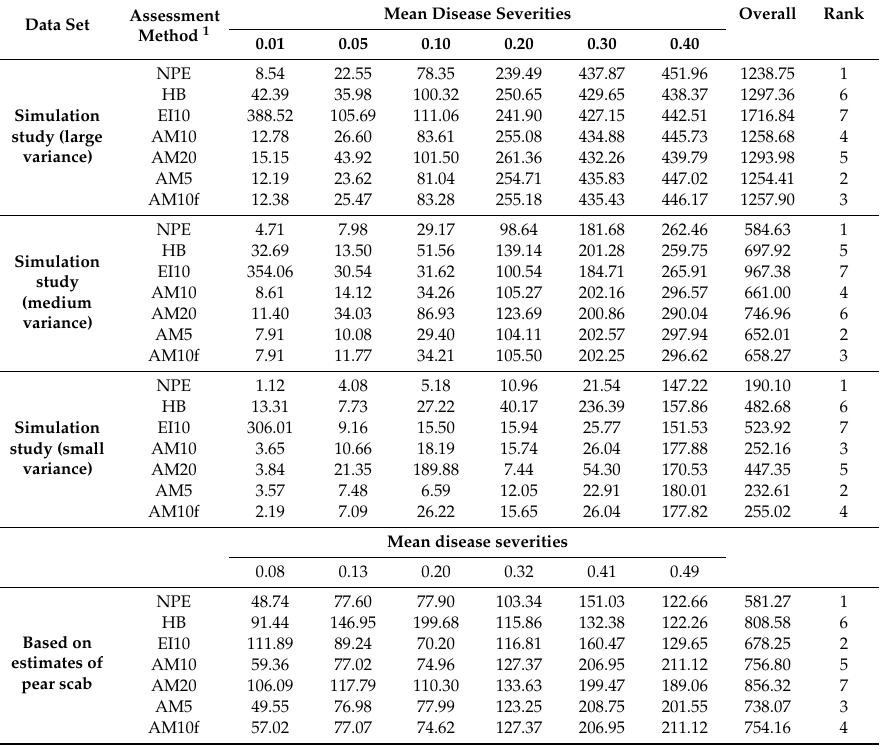
Table 1. The mean square error (MSE) for the seven assessment methods summed from n = 10 to 100 in n = 5 increments for each specific mean severity and variance (large, medium, and small) for the simulated data sets and the estimated pear scab severity data. The sums of the MSEs for all the mean disease severities were calculated (“Overall”), and a ranking (1 to 7) assigned for each assessment method, where 1 = lowest